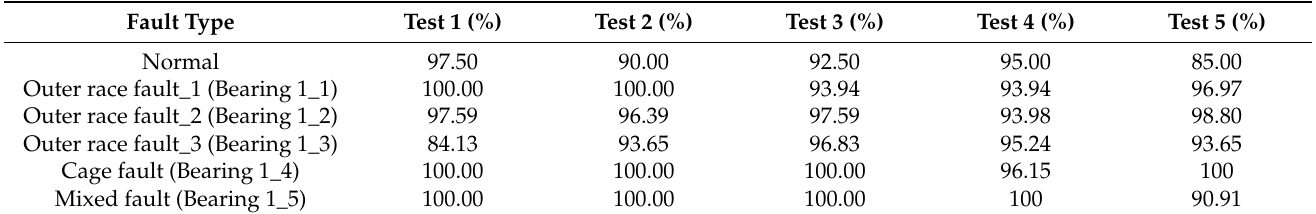
Table 6. Diagnosis accuracy of the proposed method under five-fold cross-validation.